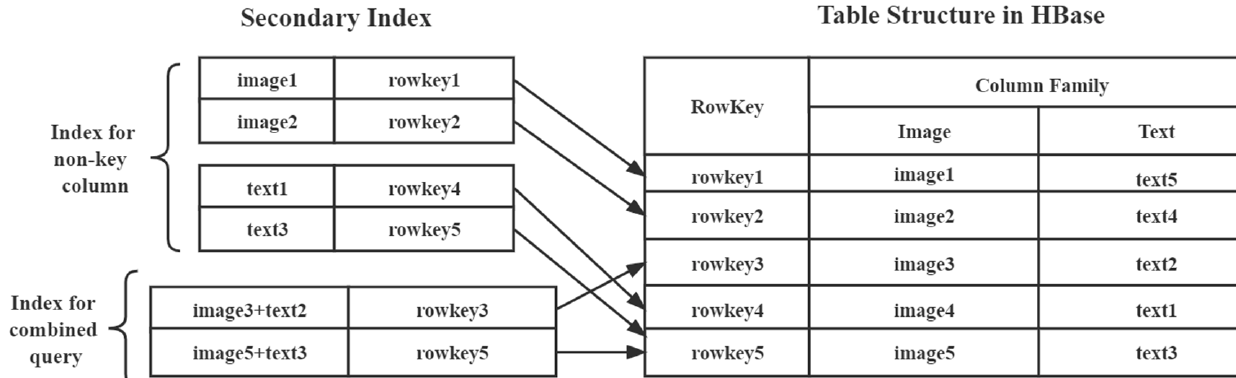
Figure 5. The secondary index in HBase.